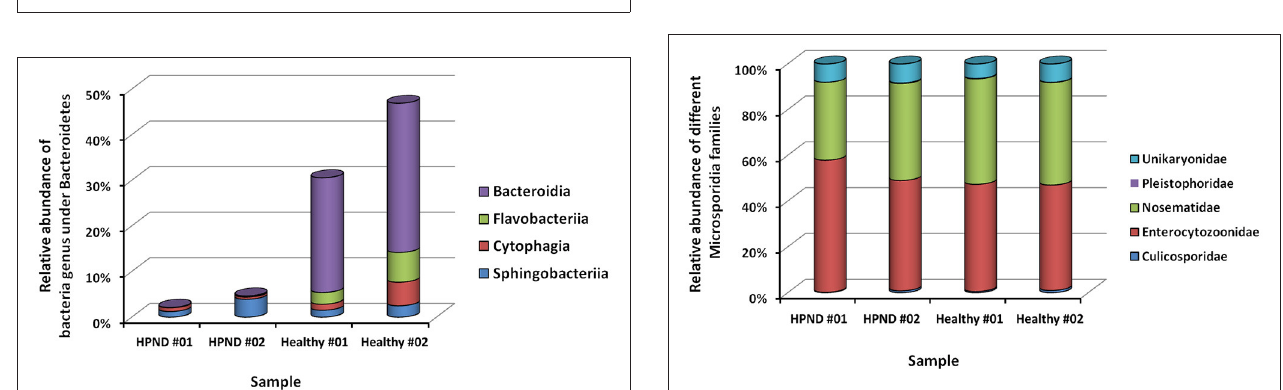
FIGURE 1 | Relative abundance of bacteria at the phylum level in crabs with and without HPND based on meta-transcriptomic data. HPND #01, HPND #02: two samples from crabs with HPND; Healthy #01, Healthy #02: two samples from crabs without HPND.